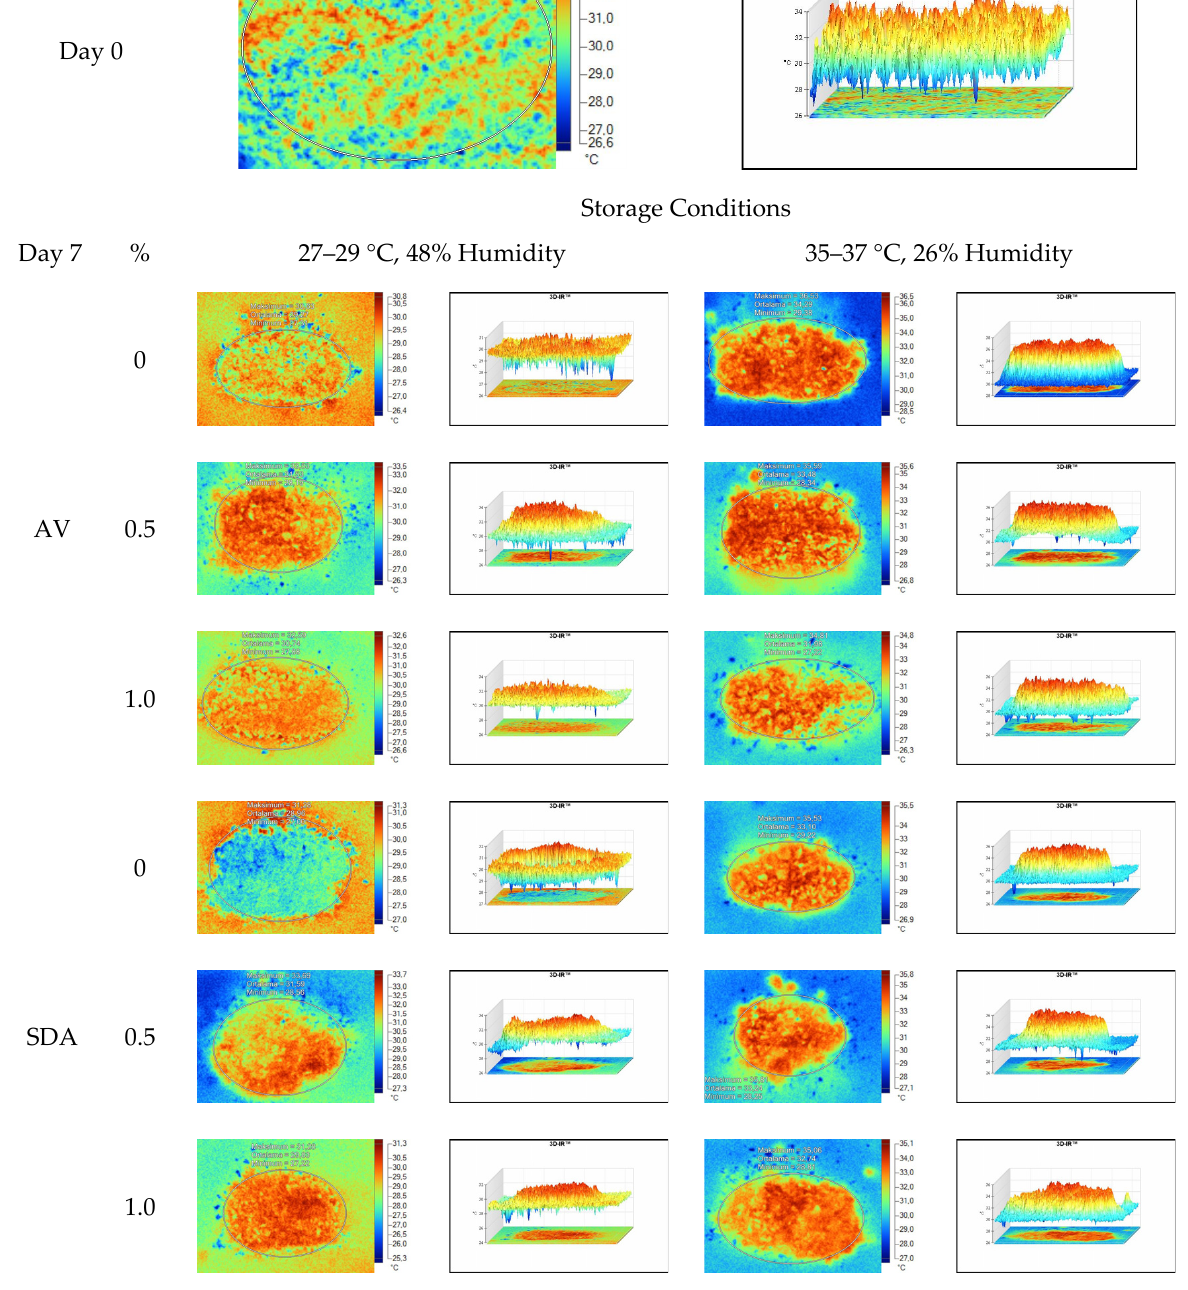
Figure 7. Thermal camera imaging samples of aerobic stability on day 7 (Ambient temperature = 22 °C; AV: Apple vinegar; SDA: Sodium diacetate).